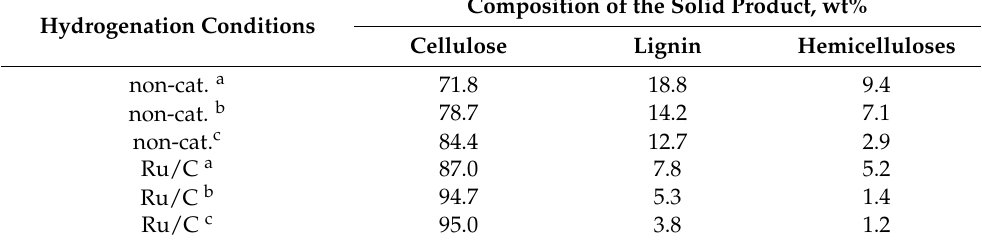
Table 6. Chemical composition of solid products of hydrogenation of initial ( a ), alkali-pretreated ( b ), acid-pretreated ( c ) birch